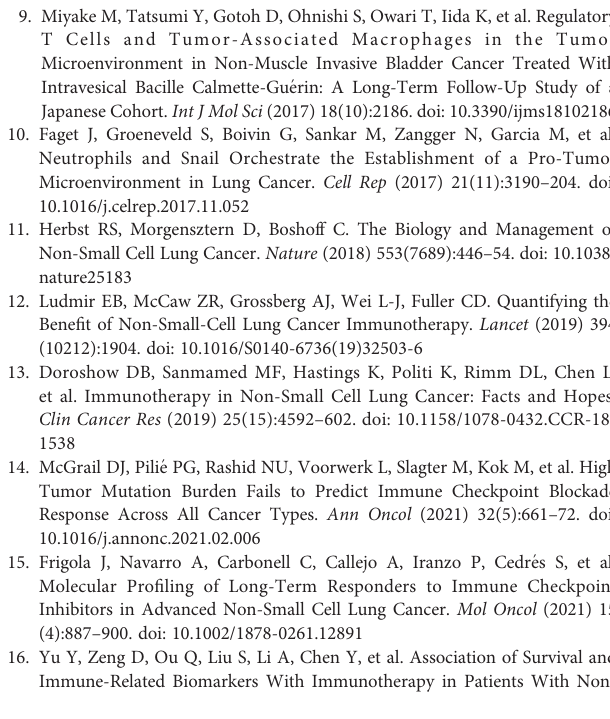
Supplementary Figure S1 | Positive and negative control used in the multiplex immuno fl uorescence (MIF) approach. (A) MIF image of lung tumor, (B) negative control MIF image from normal human tonsil tissue, and (C) positive control MIF image from normal human tonsil tissue.